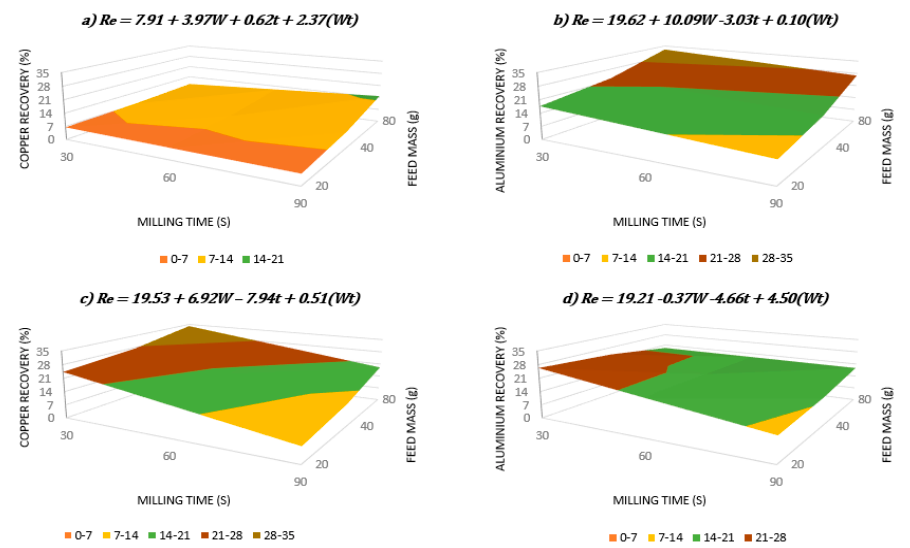
Figure 15. Surface plots of the metal recovery in the product size 1–2 mm after hammer milling as a function of feed mass and milling time: ( a ) Cu-Feed particle size fraction was 1–2 mm; ( b ) Al-Feed particle size fraction was 1–2 mm; ( c ) Cu-Feed particle size fraction was 2–4 mm; ( d ) Al-Feed particle size fraction was 2–4 mm.